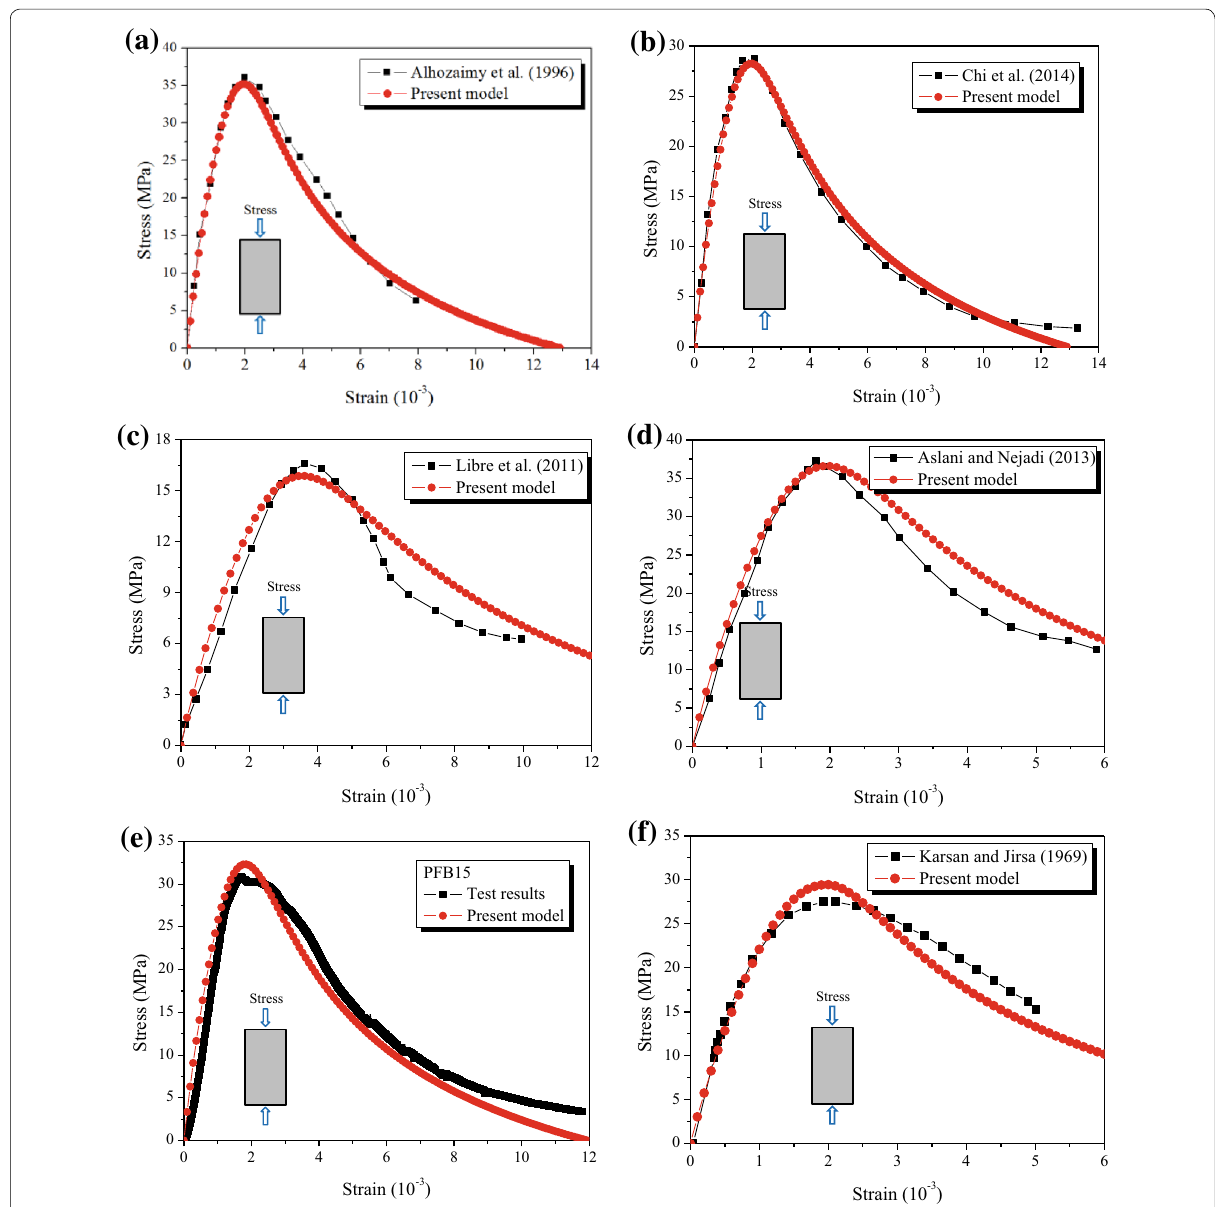
Fig. 19 Comparisons between experimental and present model results under monotonic loading. a – e PFRC. f Plain